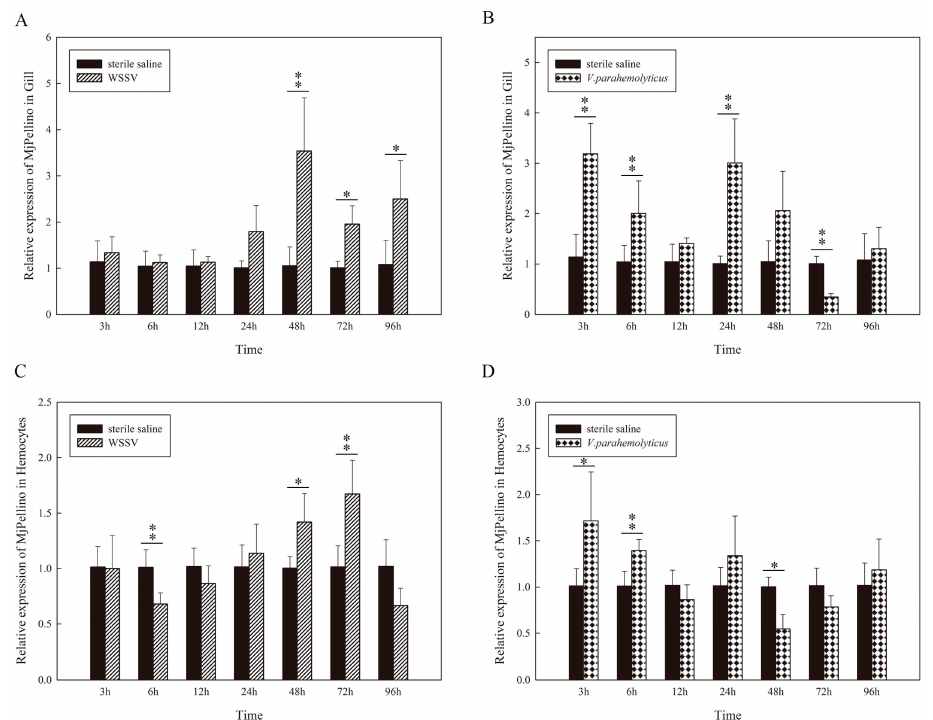
Figure 3. MjPellino mRNA expression levels in the gills and hemocytes of WSSV- and V. parahaemolyticus -challenged M. japonicus . The temporal expression patterns of MjPellino in the gills ( A ) and hemocytes ( C ) after WSSV challenge and in the gills ( B ) and hemocytes ( D ) after V. parahaemolyticus stimulation were analyzed by real-time RT-PCR. For each sample, the real-time RT-PCR analysis was performed in triplicate. A significant di ff erence compared with the control sample at each time point ( p < 0.05 or p < 0.01, n = 6, ANOVA) is indicated by asterisks (* or **, respectively) above the